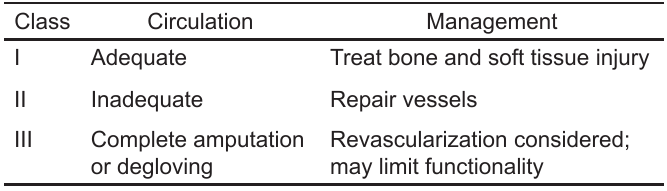
Table. Urbaniak classification for microvascular management of ring avulsion injuries.